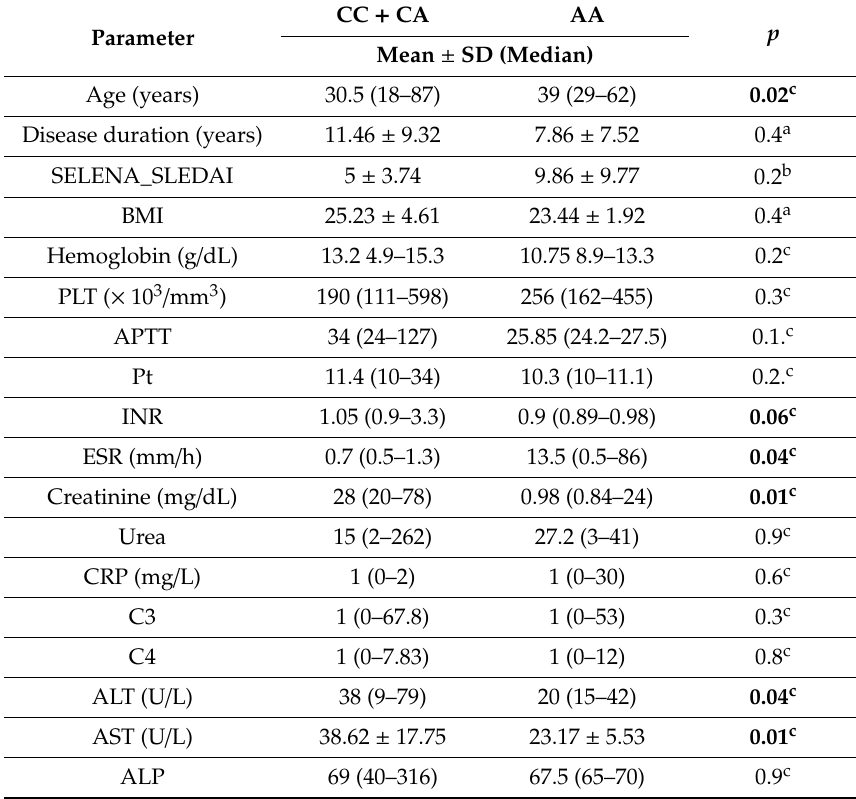
Table 4. Disease activity and laboratory variables in relation to MECP2 rs1734787 C / A, dominant